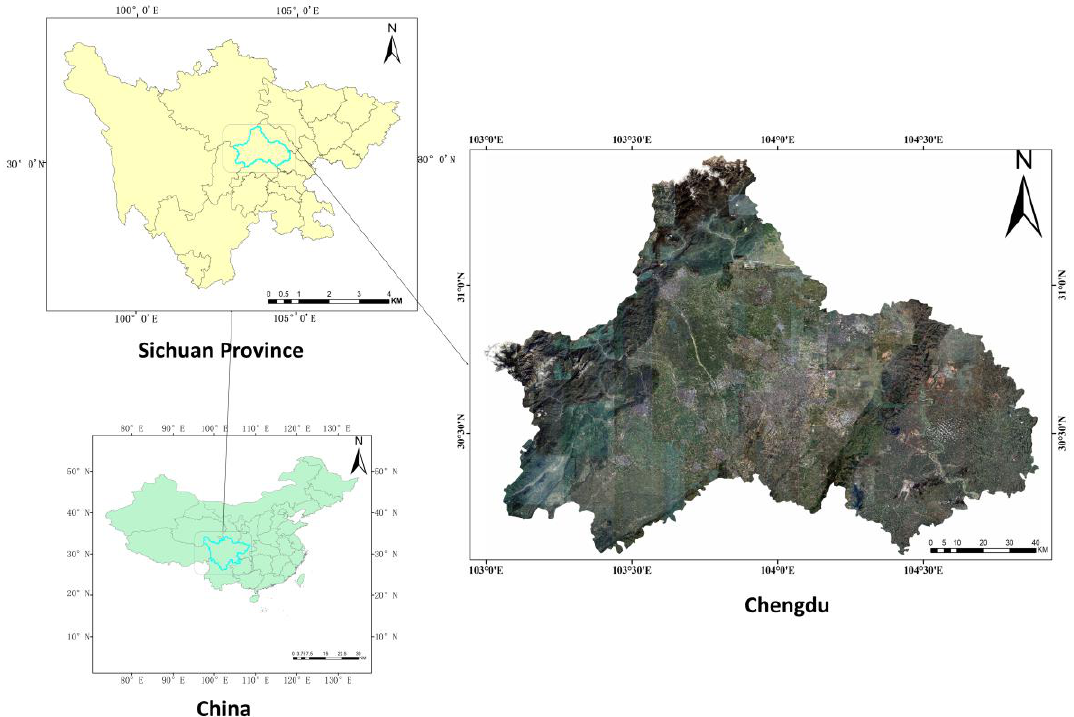
Figure 1. Geographical location and remote sensing image of the study area.